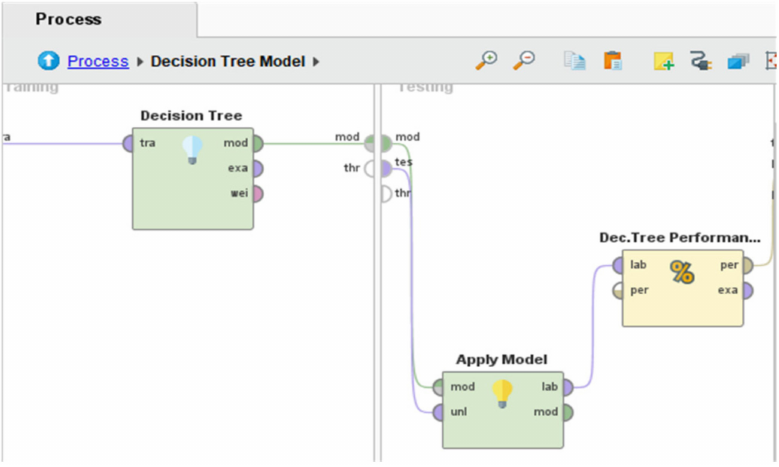
Figure 3. Inside view of cross validation (training and testing model) (step